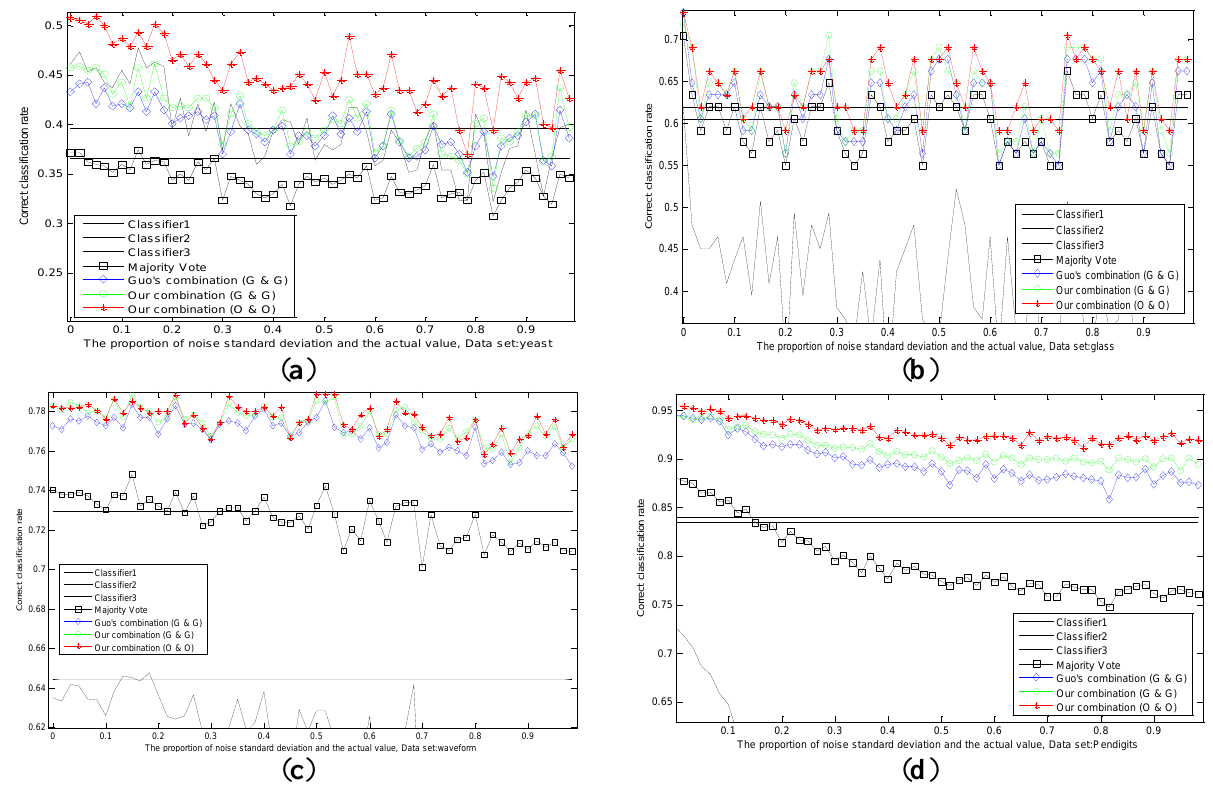
Figure 7. Results of different methods on dataset yeast ( a ), glass ( b ), waveform ( c ), and pendigits ( d ) by adding the fixed Gaussian